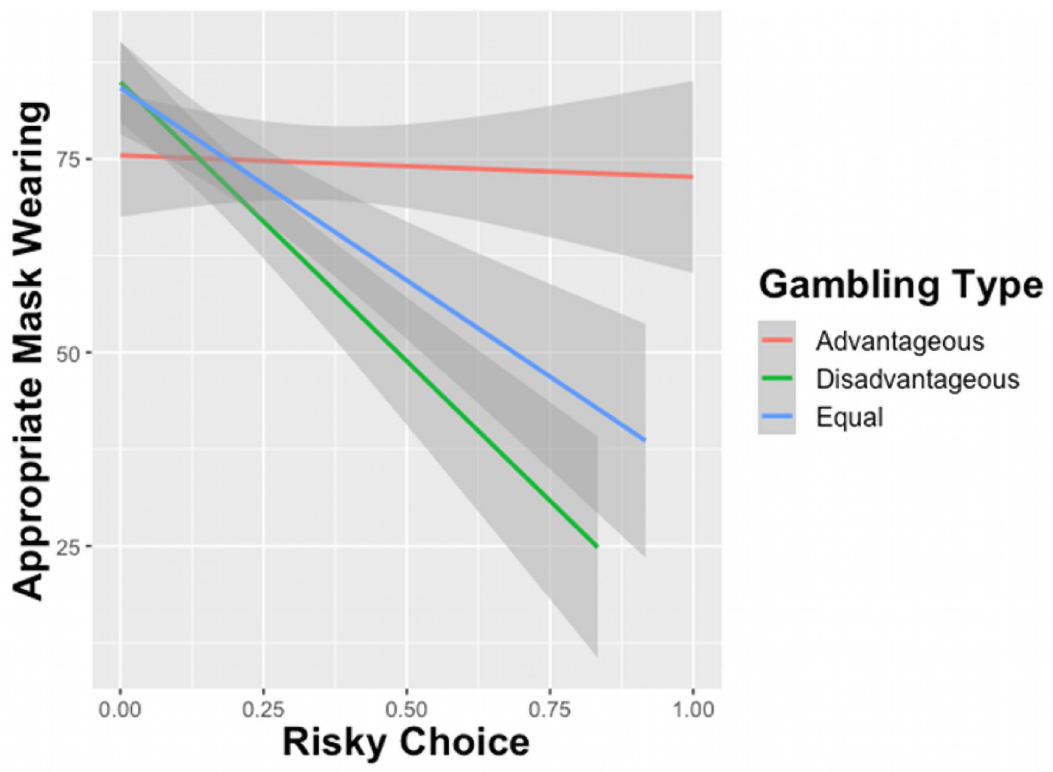
Fig 1. Effect of risky choice on appropriate mask wearing behavior by gambling type. Advantageous gambles indicate that the expected value for the risky choice was higher than the safe gamble. Disadvantageous gambles indicate that the expected value for the risky option was lower than the safe option, and the expected values for both safe and risky choices were the same for Equal gambles. Results show that choosing a higher proportion of Disadvantageous and Equal Gambles predicted less mask-wearing behavior.